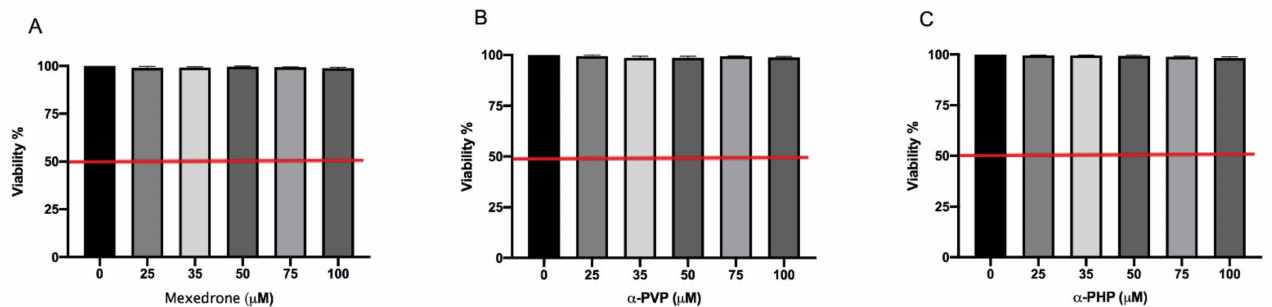
Figure 1. Cell viability on TK6 cells after 26 h treatment with mexedrone ( A ), α -PVP ( B ), α -PHP ( C ) at the indicated concentrations compared to the negative control [0 µ M]. Each bar represents the mean ± SEM of five independent experiments. Data were analyzed by ANOVA Repeated followed by Dunnet post-test.